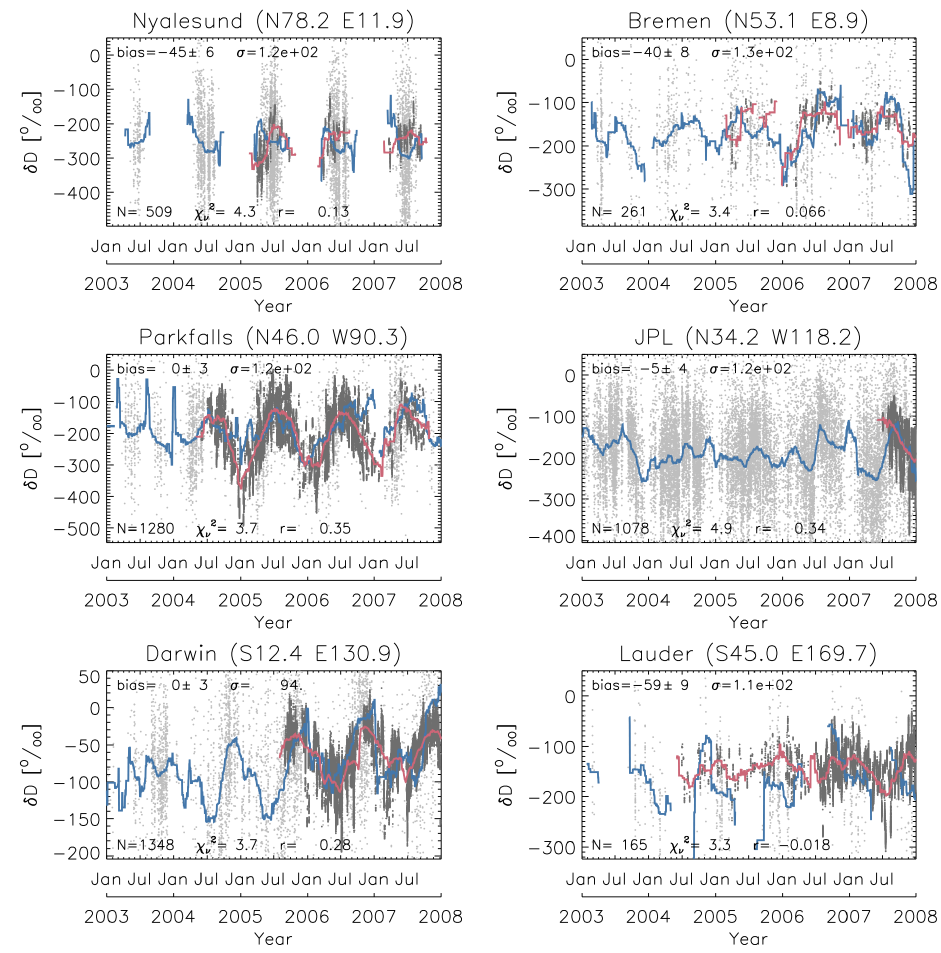
Figure 5. Time series of δD from six TCCON stations (dark grey dots and magenta curve) compared with δD from SCIAMACHY within a 500km radius (light grey dots and blue curve, offset corrected). The curves are 60-day running averages. For the statistics an additional temporal constraint of ± 2h was used, but no temporal constraint has been applied to the plotted data